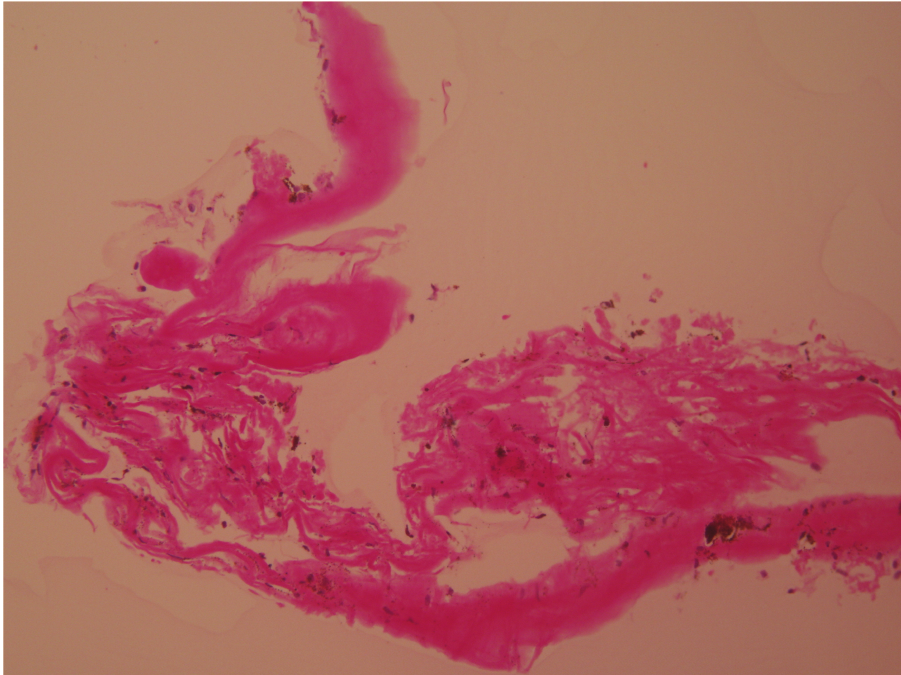
Figure 2. Histologic specimen of human trabecular meshwork following excision with a modified 25-gauge hypodermic needle. Light micrograph, hematoxylin–eosin, 200 × magnification.